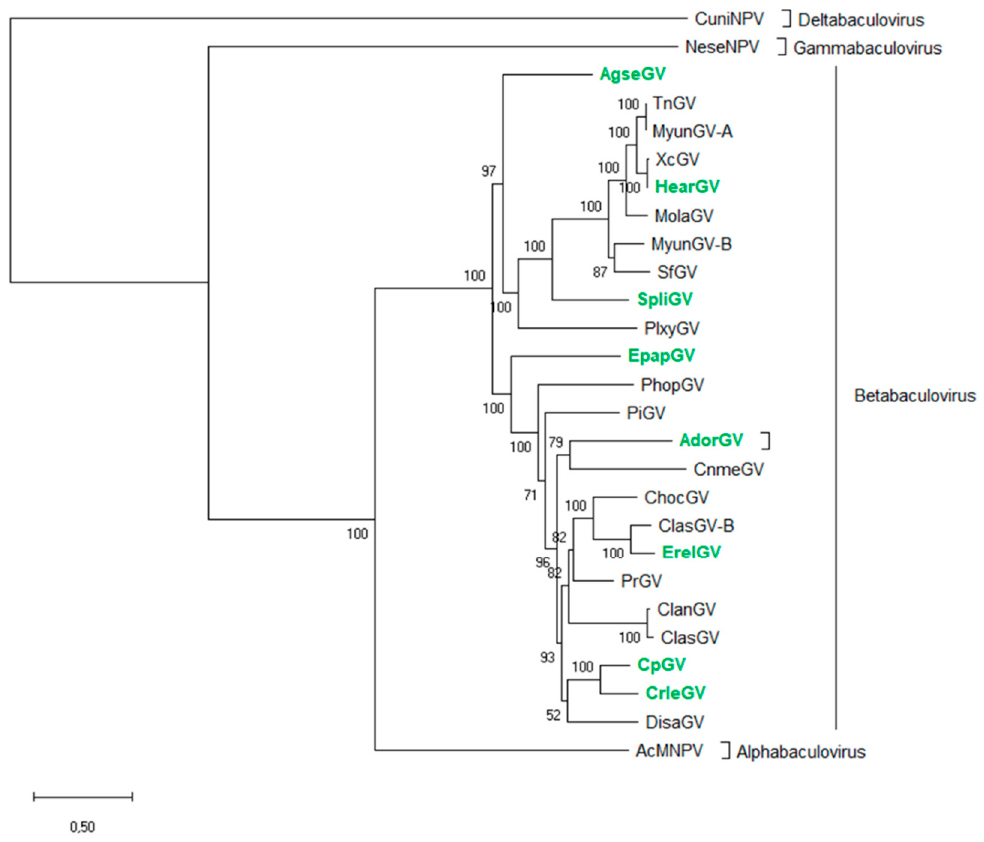
Figure 1. Maximum likelihood (ML) molecular phylogenetic tree based on amino acid sequences of 38 core genes of 24 baculovirus species from the Betabaculovirus genus and one of each of Alpha -, Delta -, and Gammabaculovirus . Species marked in green indicate betabaculoviruses chosen as a representative group in this study.